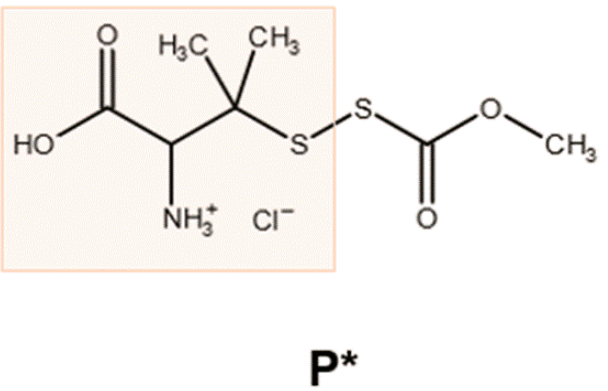
Figure 1. Chemical structure of P*. The reaction of penicillamine (orange box) with methoxycarbonylsulfenyl chloride generates the ammonium salt P*, which decomposes in the presence of thiols, leading to the generation of H 2 S and polysulfides [38].